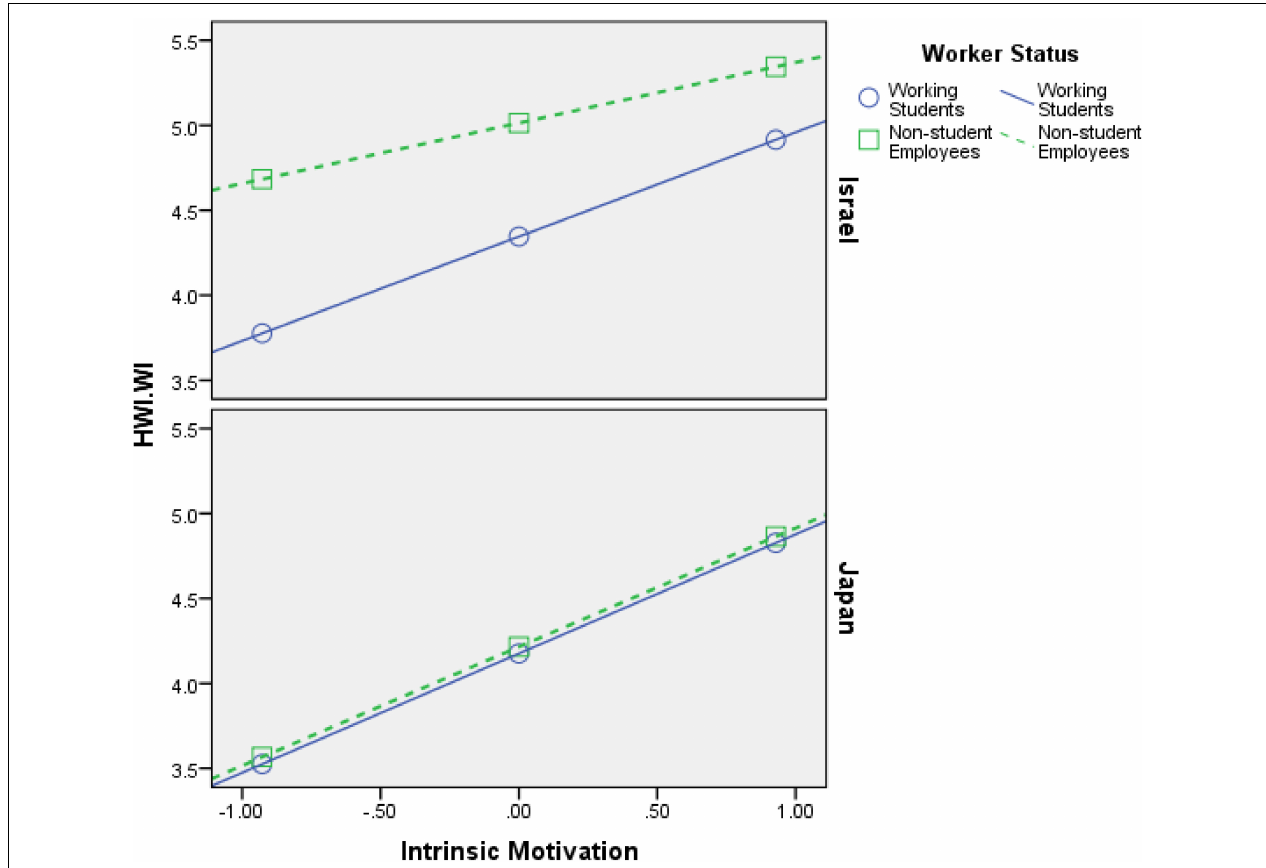
FIGURE 4 | Interaction effects of Intrinsic Motivation × Worker’s Status × Country in predicting HWI-WI. HWI-WI, work intensity dimension of heavy work